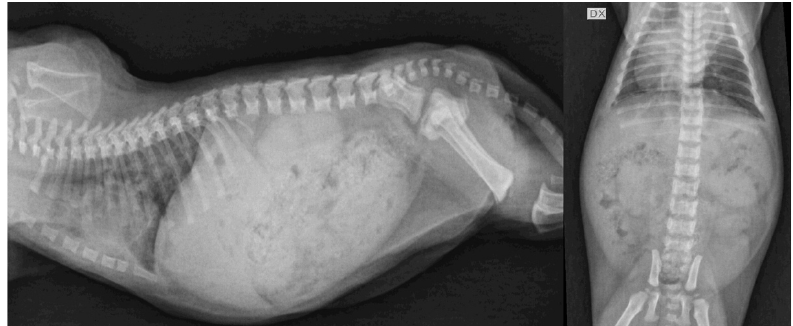
Figure 3. Lateral and ventrodorsal projections of thorax and abdomen of 1 hypothyroid kitten (F2) at the time of diagnosis. Delayed appearance of ossification centers with reduced long bone length and shortened vertebral bodies with scalloped ventral borders were observed. Right-sided displacement of the cardiac apex likely compatible with sternal malformation was also noted. Moderate distension of the gastrointestinal tract was also present. DX, right side.